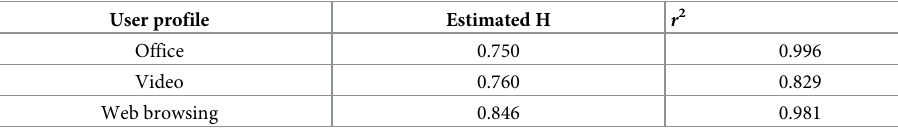
Table 3. Estimation of Hurst parameter for PCoIP